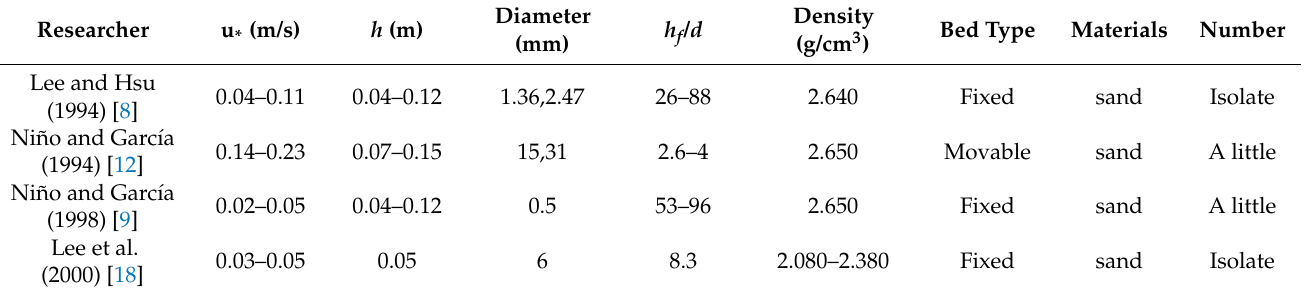
Table 2. Configuration and parameters of experiments by different investigators.